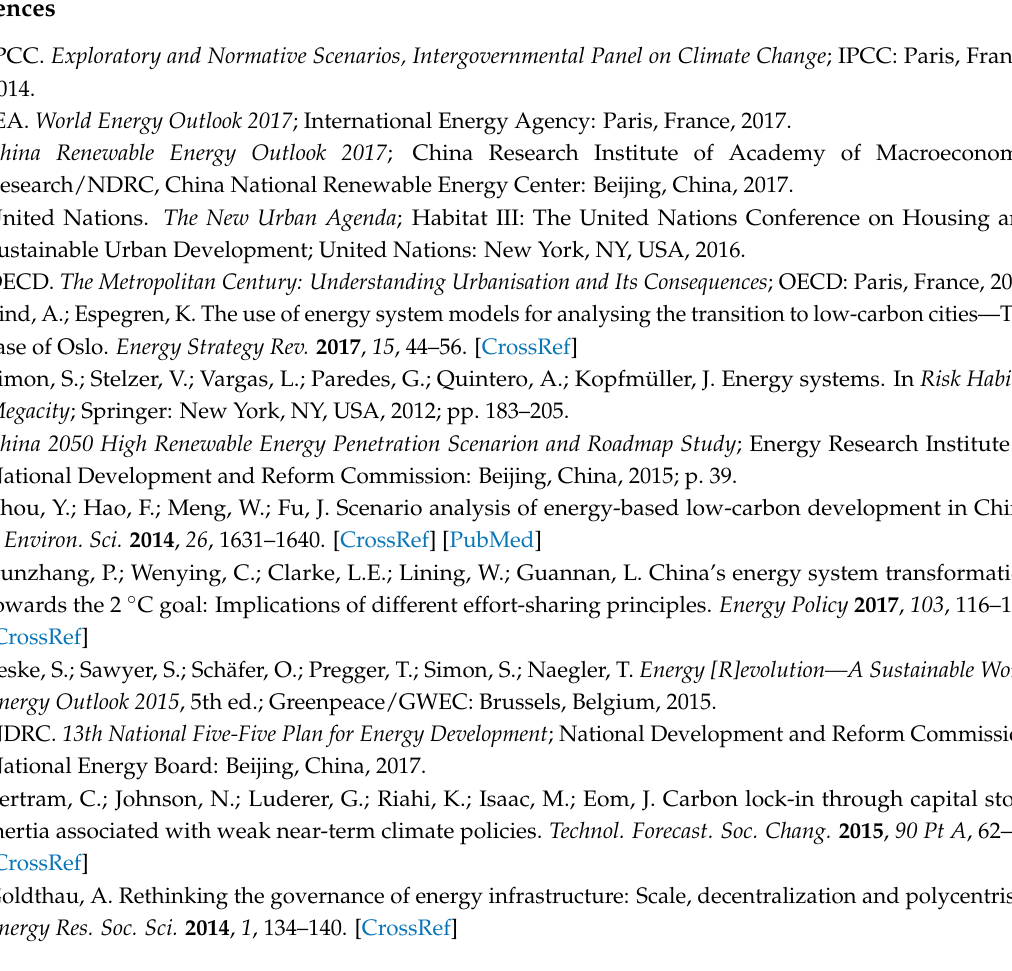
Figure A6. Energy consumption structure of study regions and China in 2015 by sector (data source: China Energy Statistical Yearbook 2016 [17]).